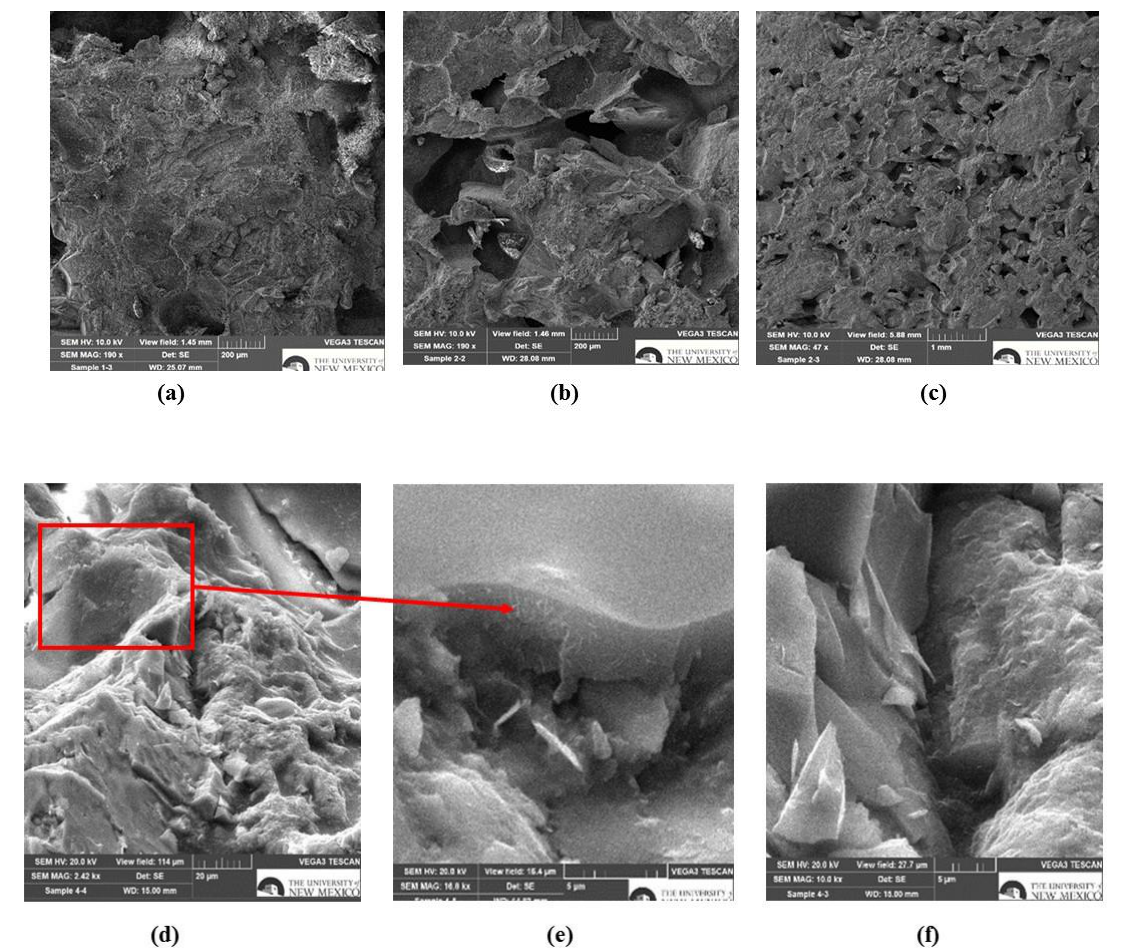
Figure 9. Scanning electron microscope (SEM) images of BPC: ( a ) PU concrete, ( b , c ) porous structure of PU containing benzoic acid, ( d ) compact structure of PU concrete with benzoic acid and MWCNTts, ( e ) presence of MWCNTs in the voids, and ( f ) presence of MWCNTs in the cracks.